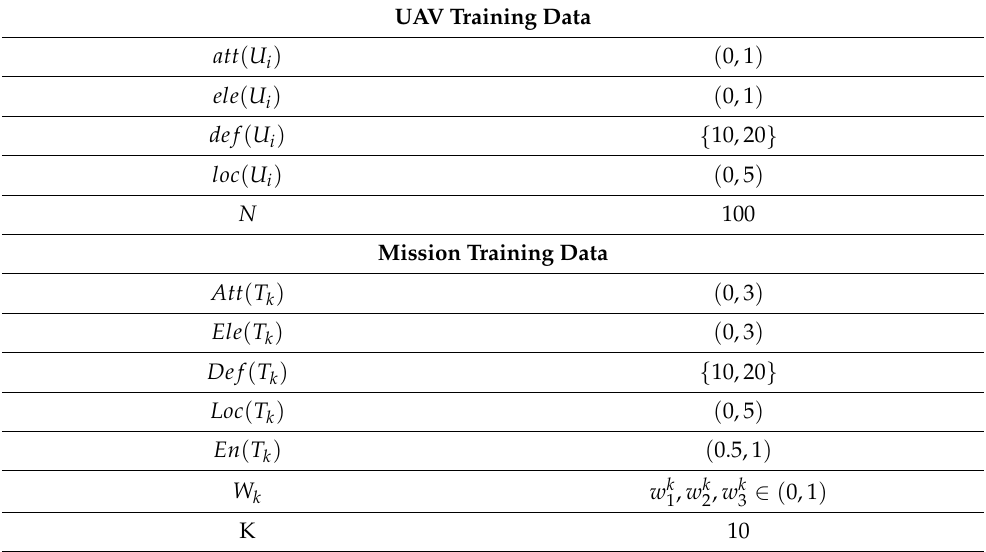
Table 4. Training data